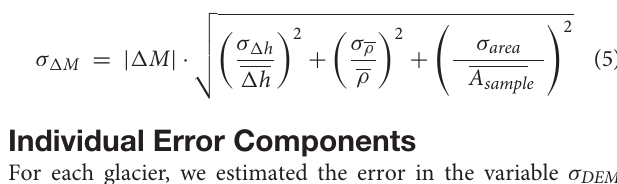
Supplementary Figure 2 indicates from which input data or processing step the individual error components originated.